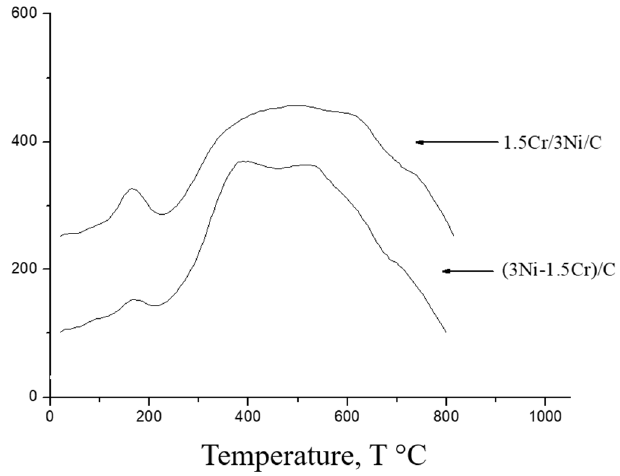
Figure 3. TPR profiles for bimetallic catalysts (3Ni-1.5Cr)/C and 1.5Cr/3Ni/ С